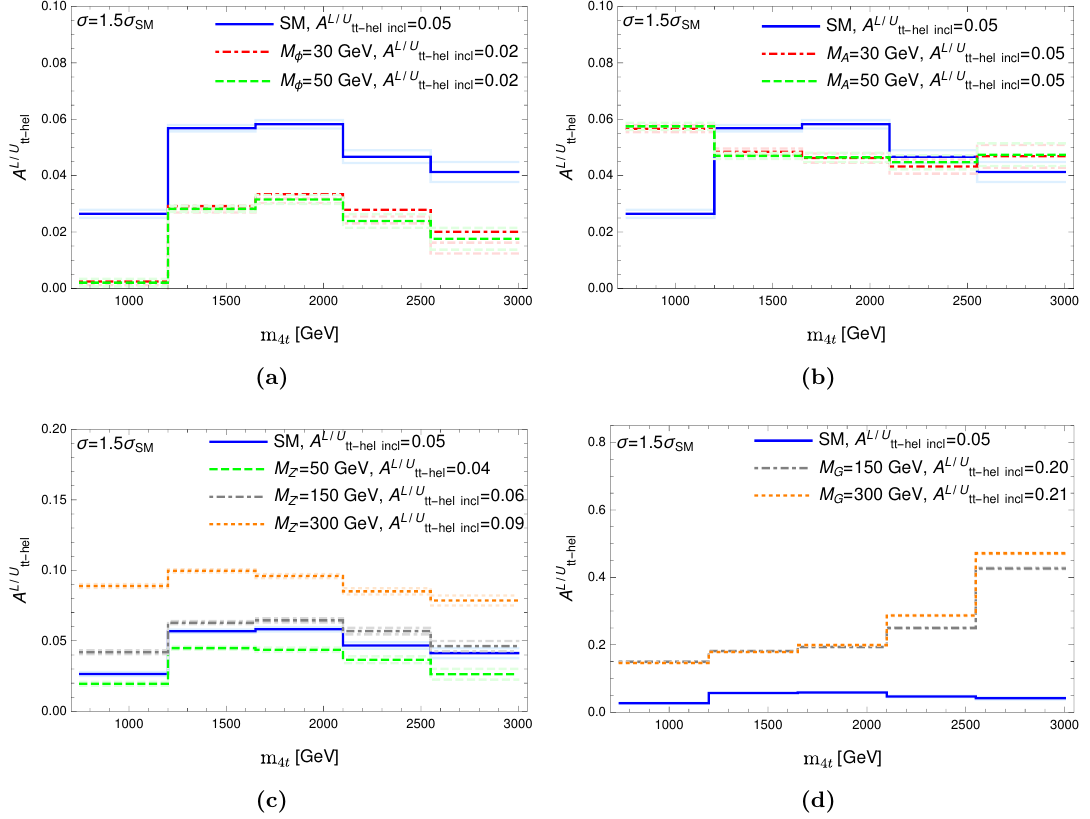
Figure 5. A L=U asymmetry (see eq. 3.1) as a function of the invariant mass of the four-top system. tt-hel Shown are the predictions for the SM (blue) and the tight benchmark points (i.e. giving (cid:27) = 1 : 5 (cid:27) SM ) of the NP models considered: (a) Scalar, (b) Pseudo-scalar, (c) Z 0 , and (d) Graviton. Also quoted are the inclusive asymmetries, i.e. averaged over the four-top invariant mass spectrum. Analogous results for the loose benchmark points (i.e. giving (cid:27) = 2 (cid:27) SM ) are shown in (cid:12)gure 9 in appendix A.